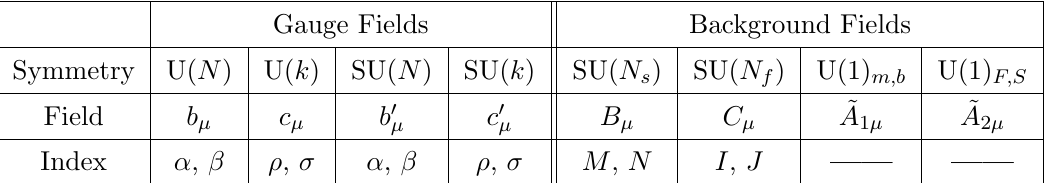
Table 1 . Collection of notation for various gauge (cid:12)elds. Note that dynamical gauge (cid:12)elds are indicated by lower case letters and background gauge (cid:12)elds by upper case